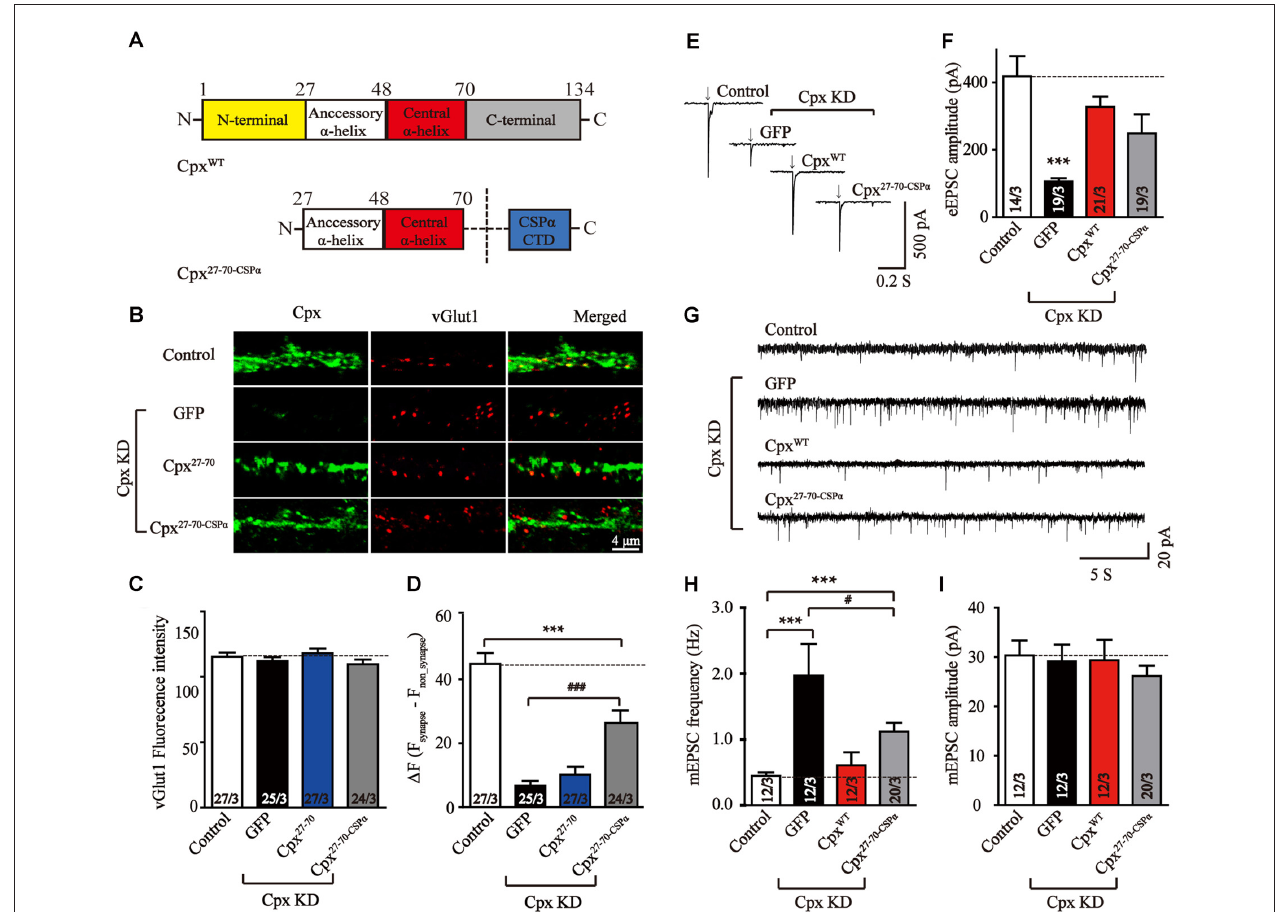
FIGURE 4 | Synaptic vesicle location is important in suppressing spontaneous release. (A) Schematic structures of wild type (Cpx WT ) and the C-terminal sequence of CSP α linked accessory and central α -helices of Cpx (Cpx 27–70 - CSP α ). (B–D) Representative images (B) and summary graphs of vGlut1 intensities (C) and ∆ F (F synapse -F non − synapse ) of Cpx fluorescence intensities (D) of cultured mouse cortical neurons infected with a control lentivirus (control) or lentiviruses expressing complexin shRNAs (GFP) without or with coexpression of Cpx 27–70 or Cpx 27–70 - CSP α , respectively. (E,F) Representative traces (E) and summary graphs of the amplitude (F) of action-potential evoked AMPAR-mediated EPSCs recorded in cultured cortical neurons that were infected with a control lentivirus (control) or lentiviruses expressing complexin shRNAs (GFP) without or with coexpression of Cpx WT or Cpx 27–70 - CSP α , respectively. (G–I) Sample trace (G) and summary graphs of the frequency (H) and amplitude (I) of mEPSCs monitored in neurons as described for (E) . Data shown in summary graphs are means ± SEM; numbers of cells/independent cultures analyzed are listed in the bars. Statistical assessments were performed by the Student’s t -test comparing each condition to the indicated control experiment ( ∗∗∗ p < 0.001) or comparing Cpx 27–70 - CSP α to Cpx knockdown (KD) alone (GFP) experiment ( # p < 0.05, ### p <